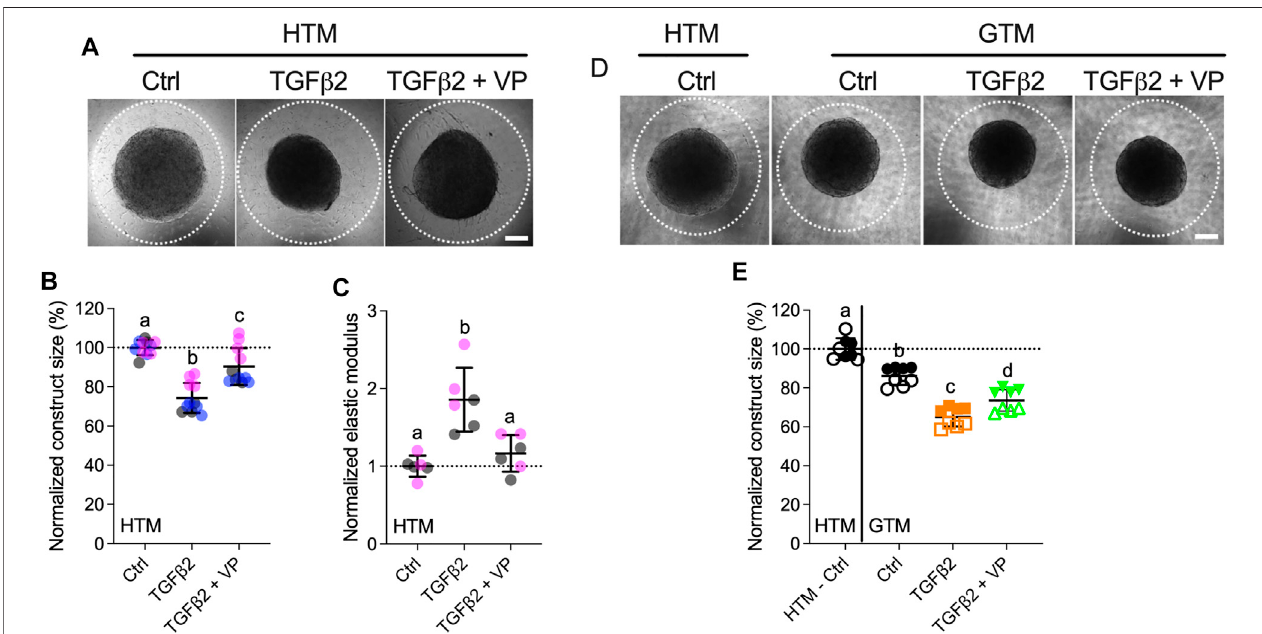
FIGURE7| InhibitionofYAP/TAZ activity decreasesHTM hydrogelcontractility and stiffness. (A) Representativebright fi eldimages ofHTM hydrogels subjected to control, TGF β 2 (2.5 ng/ml), TGF β 2 + VP (0.5 µM) at 5 days (dashed lines outline original size of constructs at 0 days). Scale bar, 1 mm. (B) Construct size quanti fi cation of HTM hydrogels subjected to the different treatments ( n = 11 replicates per group from three HTM cell strains). (C) Normalized elastic modulus (to controls) of HTM hydrogels subjected to the different treatments ( n = 6 replicates per group from three HTM cell strains). (D) Representative bright fi eld images of GTM hydrogels subjected to the different treatments at 5 days (dashed lines outline original size of constructs at 0 days). Scale bar, 1 mm. (E) Construct size quanti fi cation of GTM hydrogelssubjectedtothedifferenttreatments( n =8replicatespergroupfrom2GTMcellstrains).Open andclosedsymbols,orsymbols withdifferentcolorsrepresent differentcell strains; dotted lineshowsHTM cellcontrol meanvalueforreference.The lines and errorbars indicate Mean±SD; Signi fi cance wasdeterminedbyone-way ANOVA using multiple comparisons tests [shared signi fi cance indicator letters represent non-signi fi cant difference ( p > 0.05), distinct letters represent signi fi cant difference ( p <